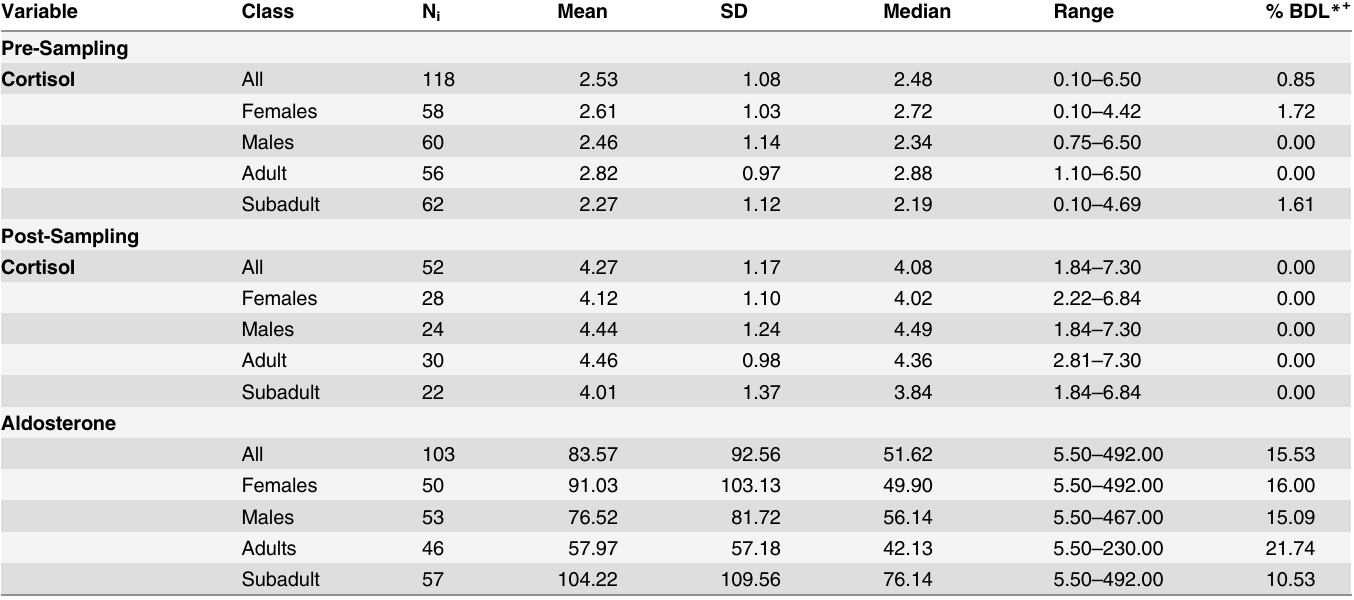
Table 1. Descriptive Statistics.